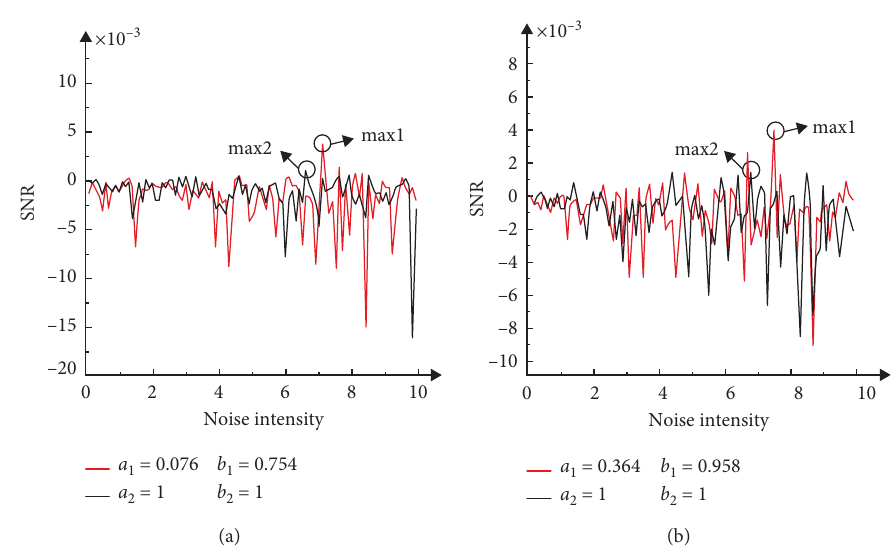
Figure 5: SNR variation of (a) analog signal X